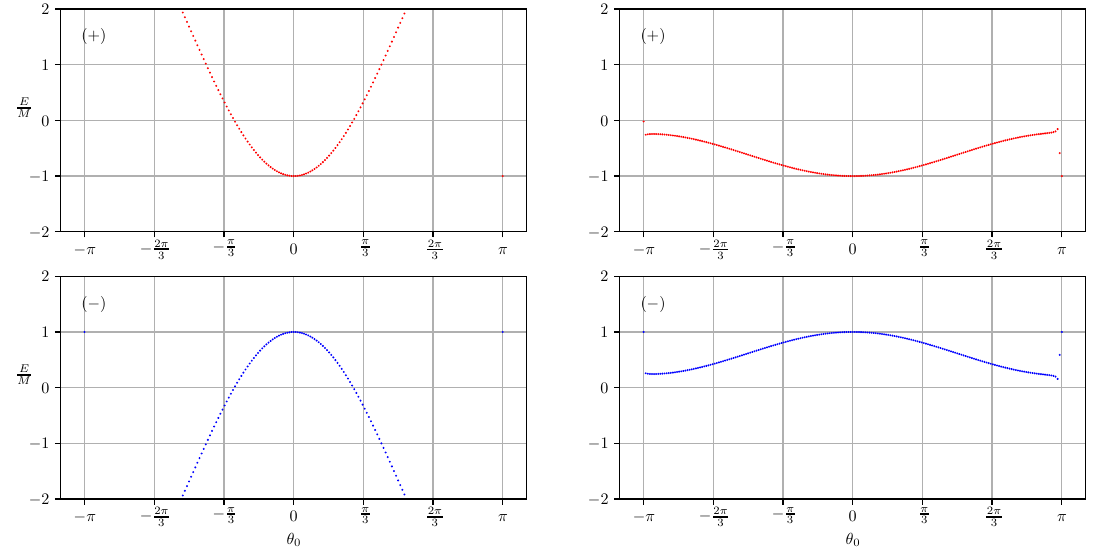
Figure 22 . E vs θ 0 . The parities of the bound states are indicated as ( ± ) . Notice the BIC states M in the left column such that | E | > 1 in some regions of θ 0 M